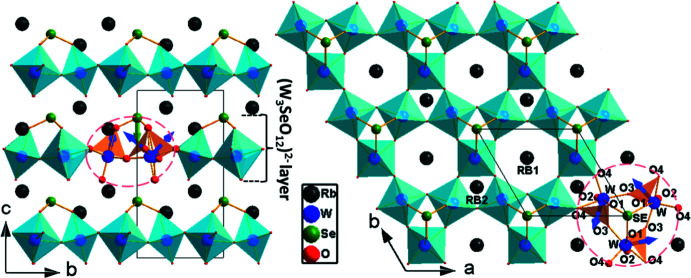
Polyhedral representation of (left) the unit-cell structure viewed along the a axis and (right) a (W3SeO12)2− layer along with the Rb+ counter-cations, viewed along the c axis, of Rb2W3SeO12 (3). A W3O15 moiety with a pyramidal selenium atom is indicated by a dashed red line and the net dipole directions of the WO6 octa­hedra and pyramidal SeO3 are shown.